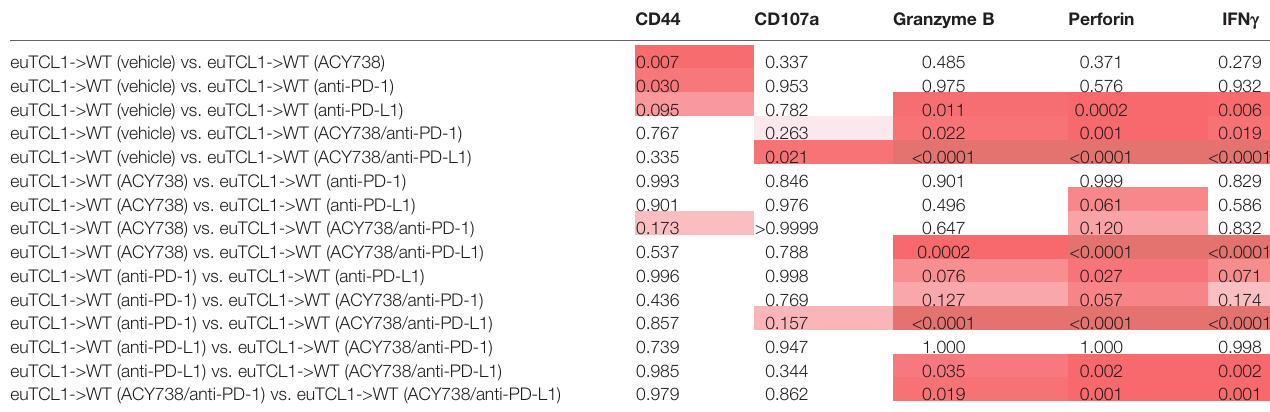
Color scale represents p